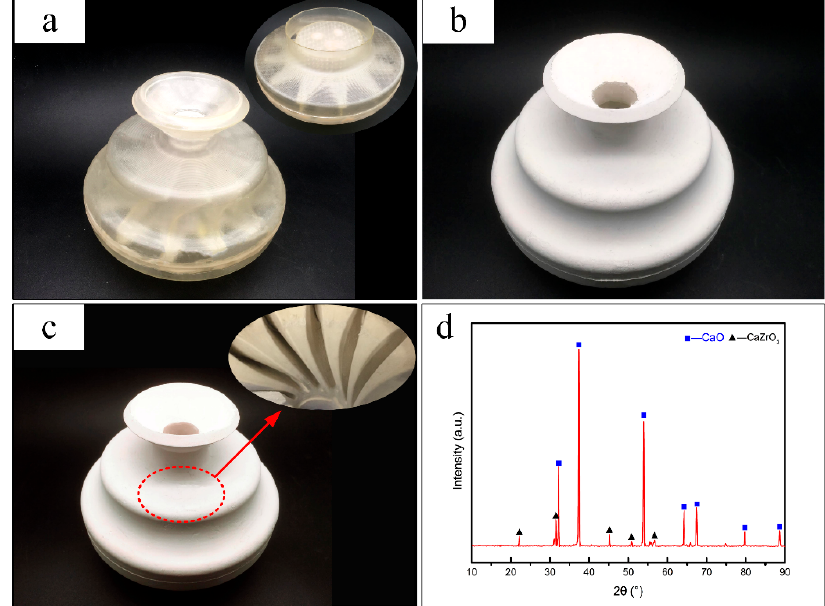
Figure 12. Fabrication of a CaO-based integral ceramic impeller mould and the XRD pattern of the mould: ( a ) SLA mould of impeller, ( b ) dried CaO-based ceramic body of impeller, ( c ) sintered CaO-based ceramic mould of impeller, ( d ) XRD pattern of the CaO-based sintered ceramic mould.